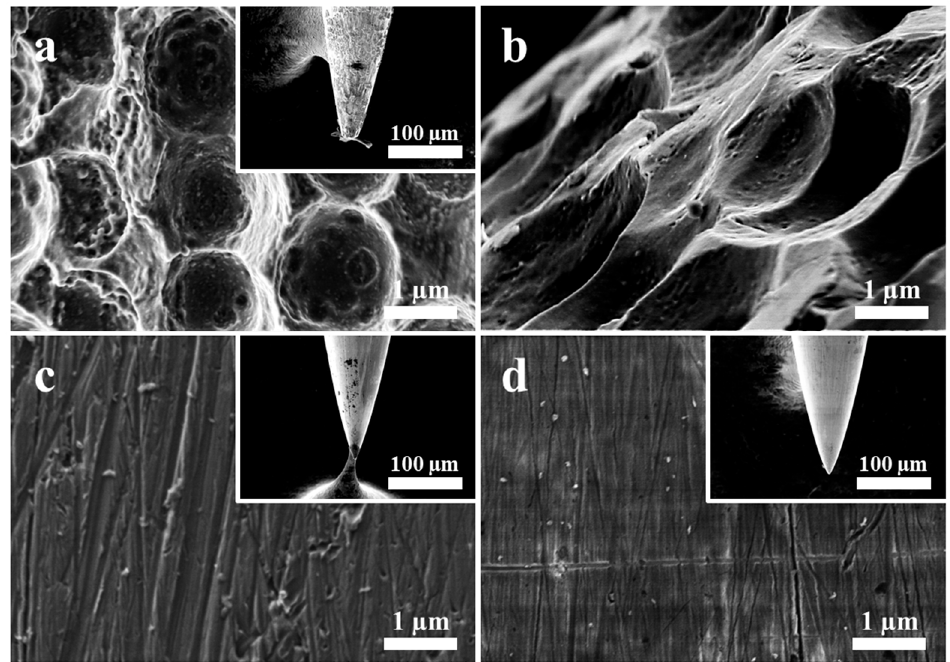
Figure 2. FE-SEM images of ( a ) porous electrode (PE), ( b ) cross-section of PE, ( c ) conventional electrode processed in 10% H 2 O 2 immersion (10%-HIE) and ( d ) silicon-coated conventional electrode in 10% H 2 O 2 immersion (Si-10%-HIE). Insets of (a,c,d) show electrode